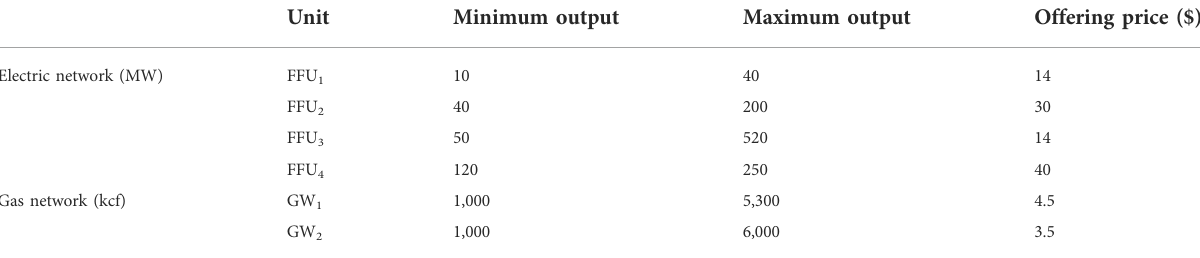
TABLE 1 Parameters of units and gas wells in the electric system and natural gas